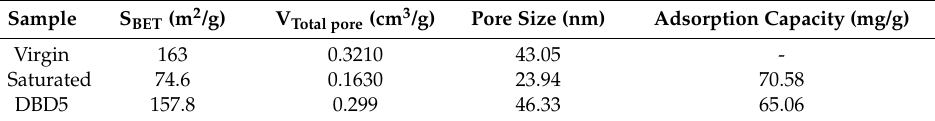
Table 2. Structural characteristics of virgin, saturated, and regenerated